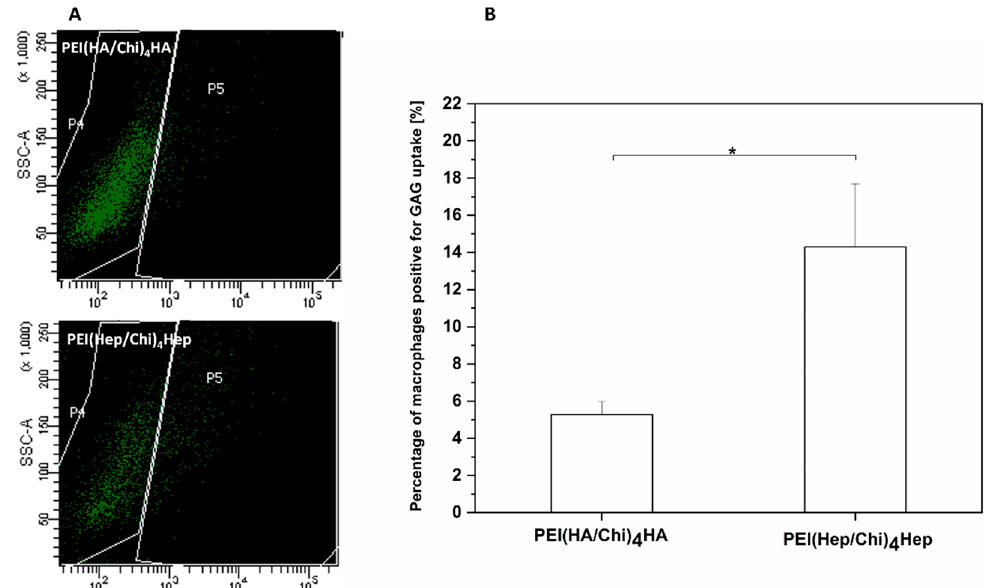
Figure 11. ( A ) Illustrative images of the flow cytometry measurements of GAG association and uptake by macrophages cultured on either FITC-labelled hyaluronic acid or FITC-heparin multilayers abbreviated as (PEI(HA/Chi) 4 HA, PEI(Hep/Chi) 4 Hep), respectively. ( B ) The percentage of macrophages positive for GAG uptake after 48 h cultivation on PEI(HA/Chi) 4 HA and PEI(Hep/Chi) 4 Hep. Data represent means ± SD, n = 4, * p ≤ 0.05.